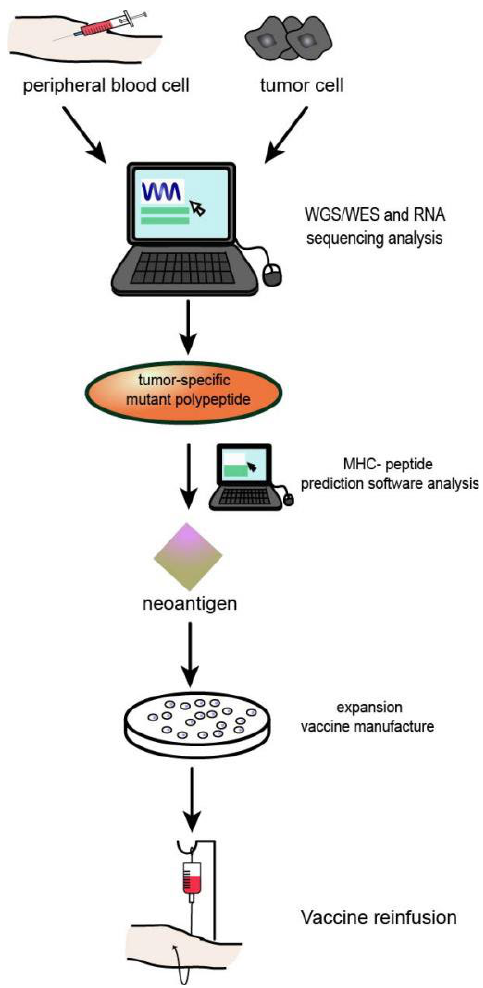
Figure 4. Process of neoantigen vaccine preparation: (1) Genome or whole exon sequencing was performed using tumour tissues and normal somatic cells. (2) Tumour tissue transcriptome sequencing. (3) Prediction and/or detection of mutated peptides and MHc molecular affinity. (4) Effective tumour neoantigens were synthesized into corresponding types of vaccines.